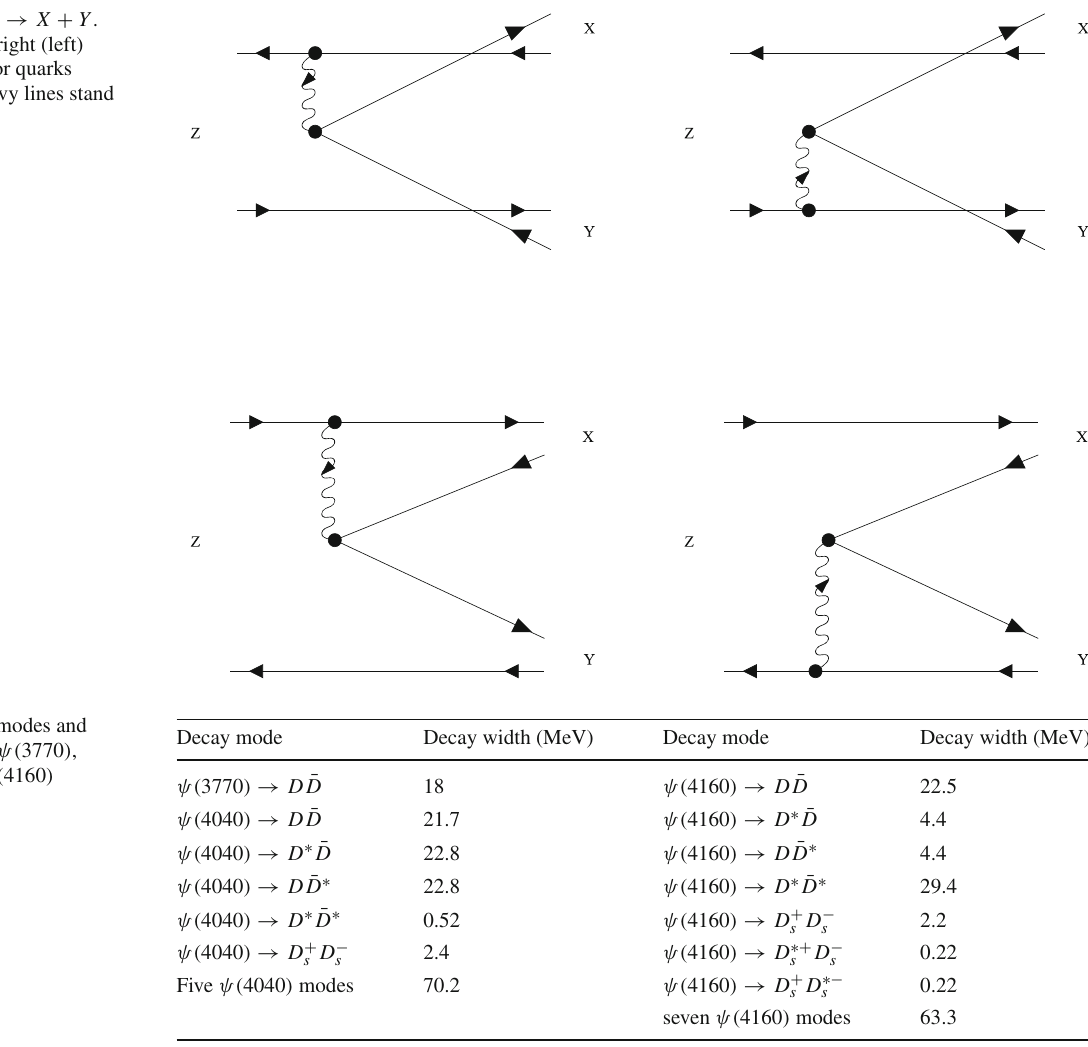
Fig. 6 Decay Z → X + Y . Solid lines with right (left) triangles stand for quarks (antiquarks). Wavy lines stand for gluons